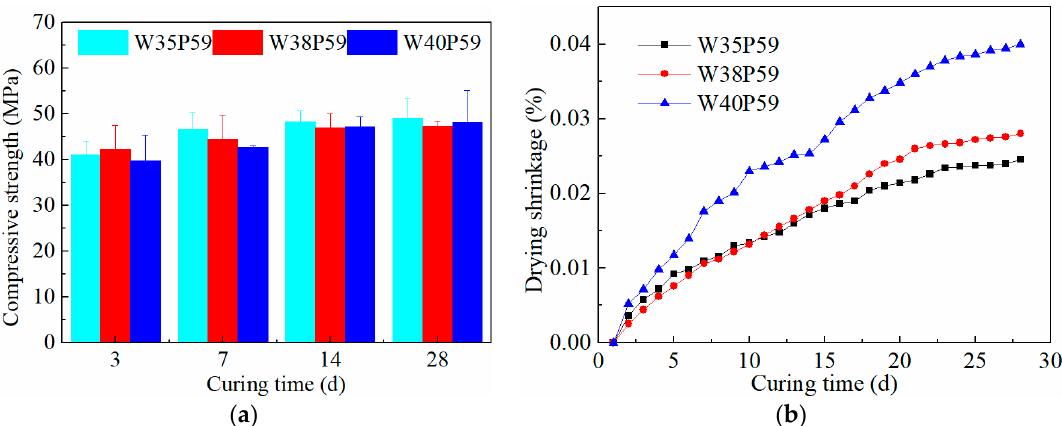
Figure 6. Effect of water to slag ratio on ( a ) compressive strength of alkali-activated slag concrete (AASC) specimens; ( b ) drying shrinkage of AASC specimens.